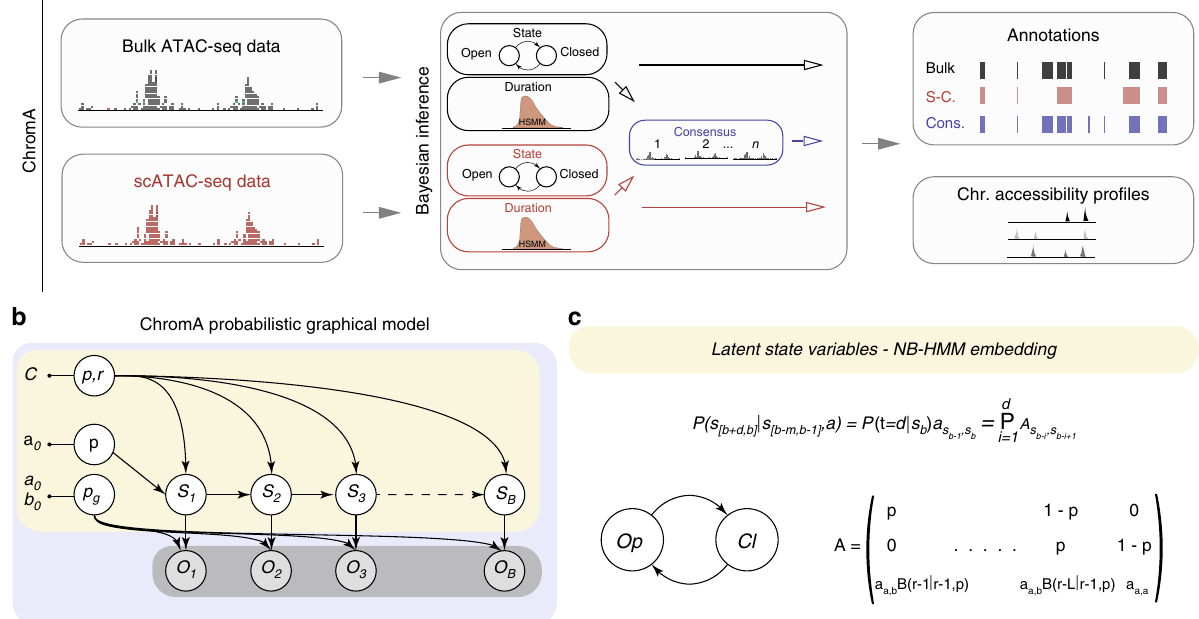
Fig. 1 Overview of chromatin accessibility annotation algorithm. a ChromA is an easy to use algorithm that combines single and multiple BAM fi les (raw reads) or TSV fi les (list of Tn5-binding events) to create chromatin accessibility annotations. b Probabilistic graphical model describing ChromA ’ s structure. In this representation, nodes describe random variables and arrows depict dependencies among the variables. ChromA models the number